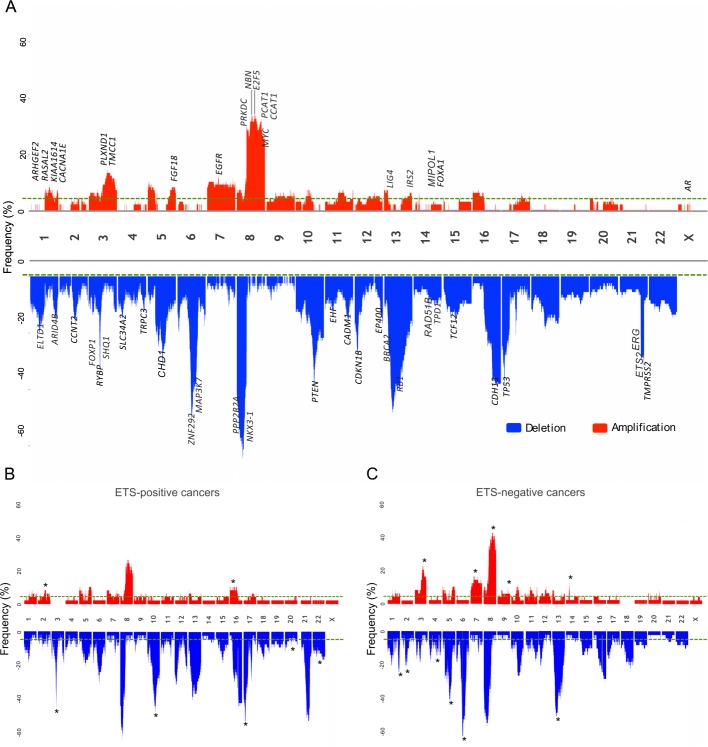
Frequency plot representing regions of amplification (red) and deletion (blue).Across samples from (A) all 103 patients, (B) ETS-positive cancers, and (C) ETS-negative cancers. SCNAs present in more than one patient were plotted. The green lines represent the cut-off (5 patients) for defining recurrently altered regions. Chromosome numbers are indicated in black. Genes potentially involved in prostate cancer development in the minimal regions of alteration are annotated in black.